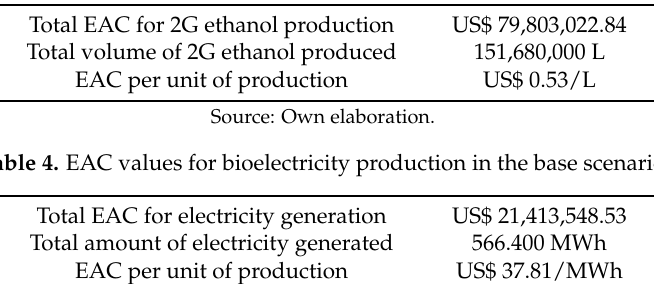
Table 3. EAC values for 2G ethanol production in the base scenario.